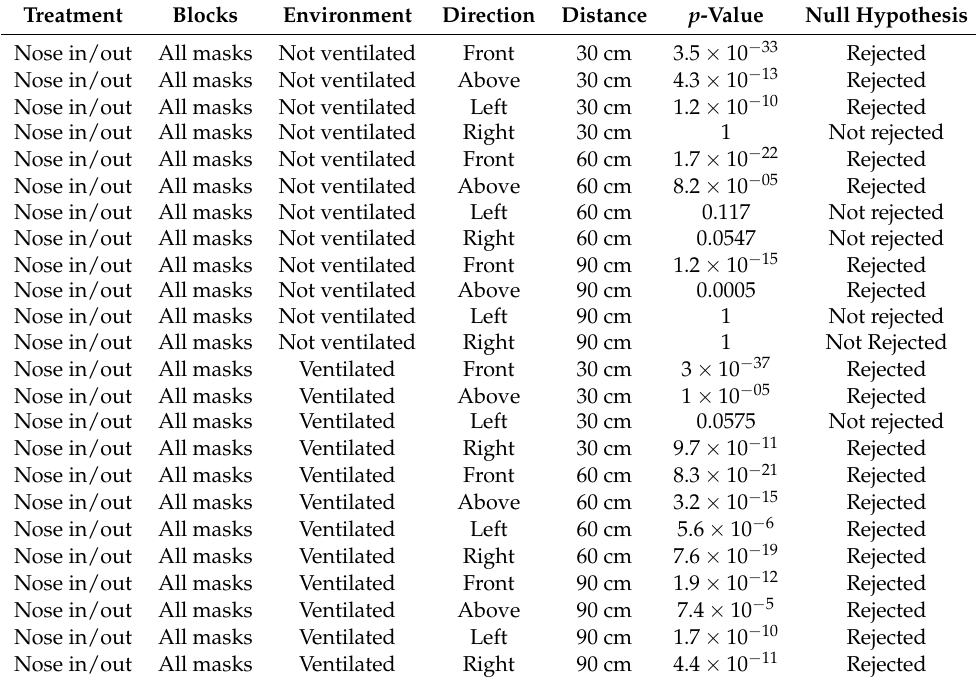
Table 1. Friedman’s